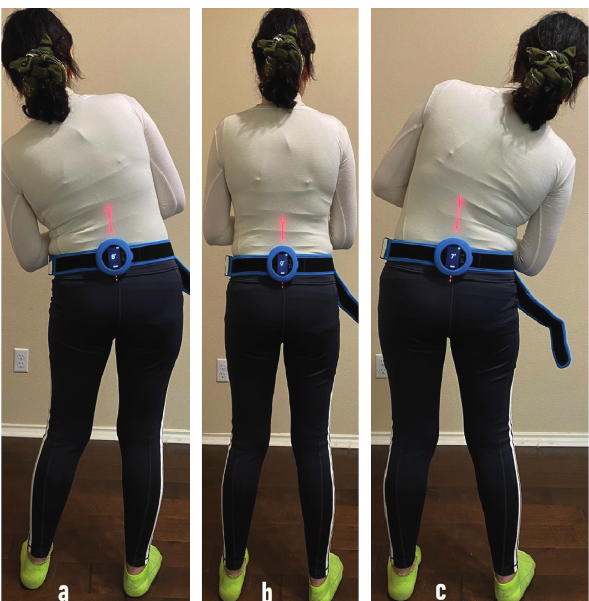
Figure 3: Measurement of the trunk (a) lateral flexion to the left, (b) neutral, and (c) lateral flexion to the right. A laser-guided digital goniometer (HALO) is fastened to a belt around the waist while